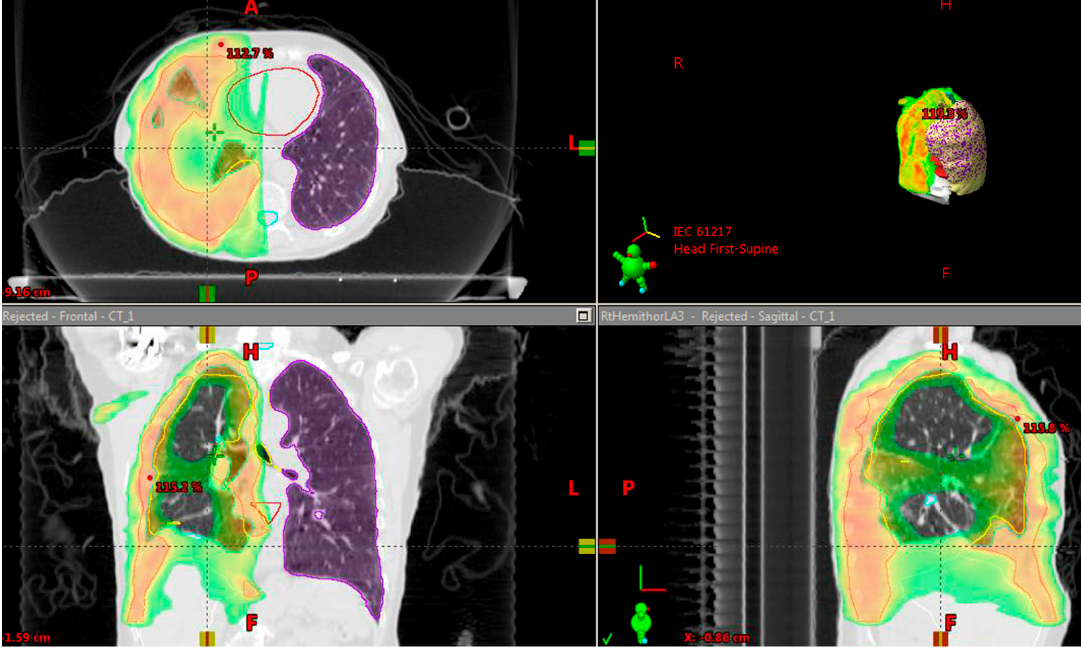
Figure 3. Showing the RT dose distribution with CPAP lung inflation allowing sparing of lung and cardiac tissue.